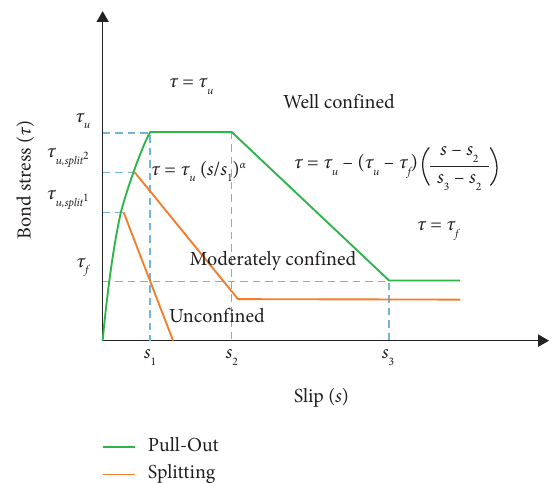
Figure 3: Te bond-slip stress relationship proposed by the CEB fb model